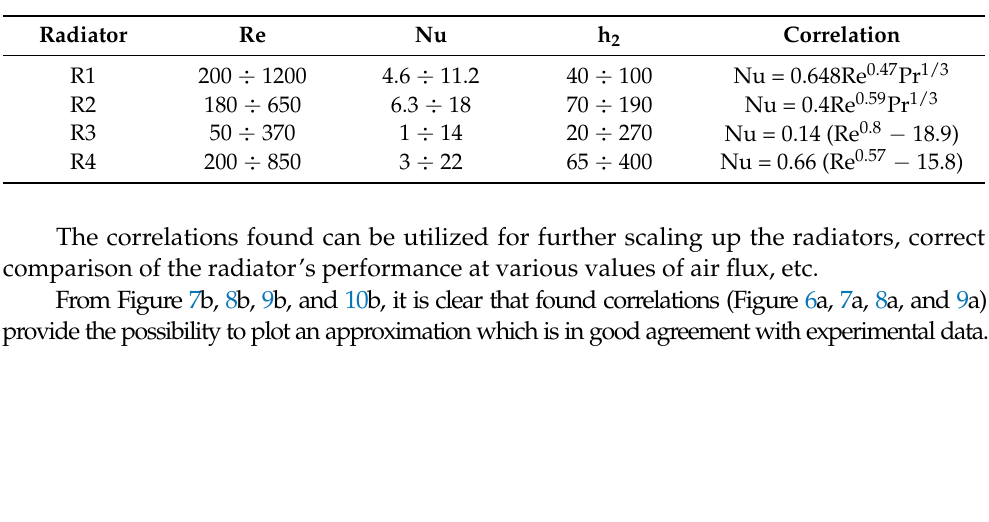
Figure 10. ( a ) Nu number correlation for radiator R4; ( b ) Comparison of experimental data (red symbols) and approximation (blue 3D surface) calculated by found correlation. Table 3. Parameters for Nusselt number correlations of tested